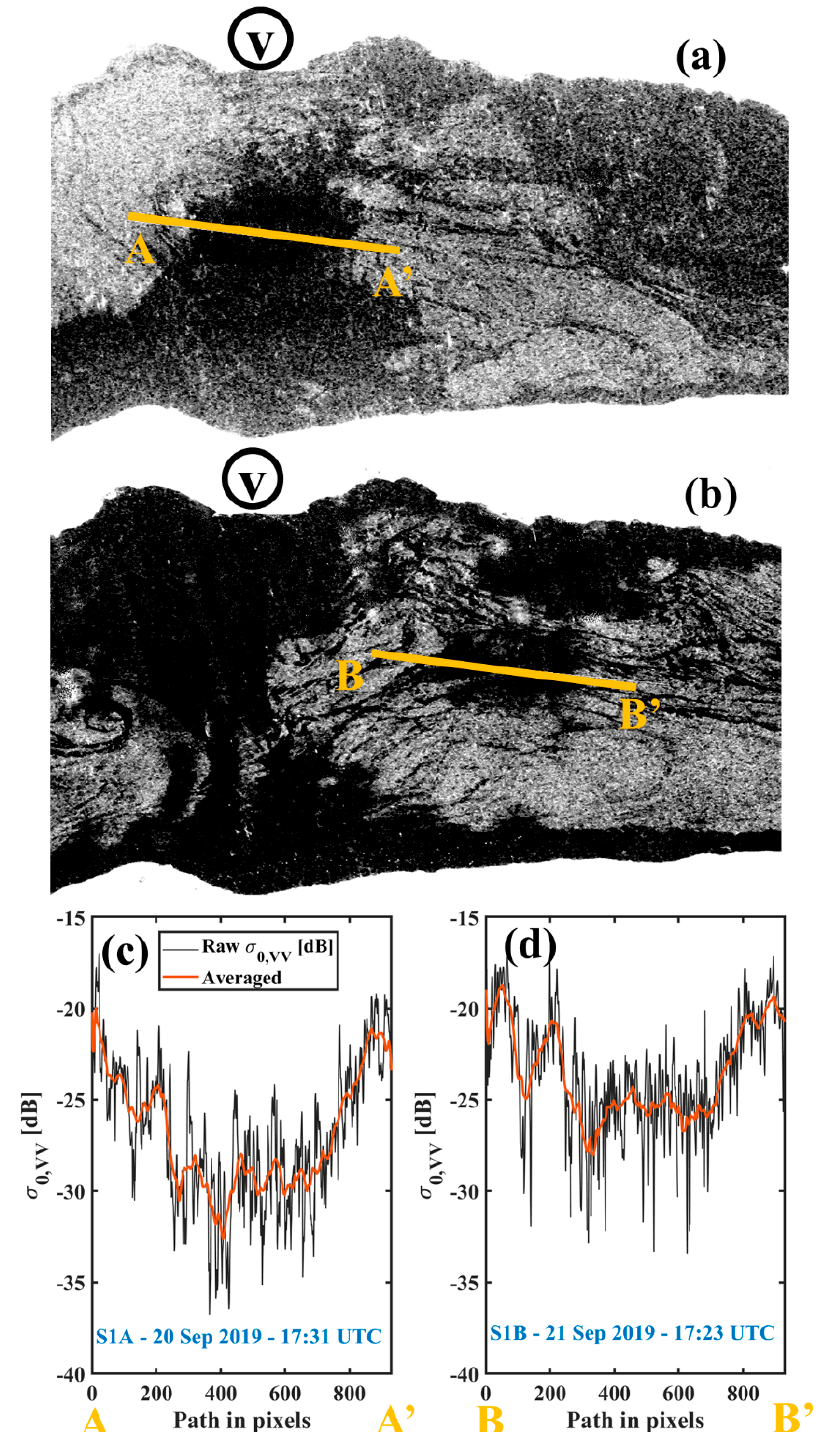
Figure 5. ( a ) Subset of a Sentinel-1A SAR-C image acquired on 20 September 2019 at 17:31 UTC. ( b ) Subset of a Sentinel-1B SAR-C image acquired on 21 September 2019 at 17:23 UTC. Variation of NRCS along the transects ( c ) A–A’ (Sentinel-1A SAR-C image) and ( d ) B–B’ (Sentinel-1B SAR-C image). V and D: reference points marked in Figure 1.